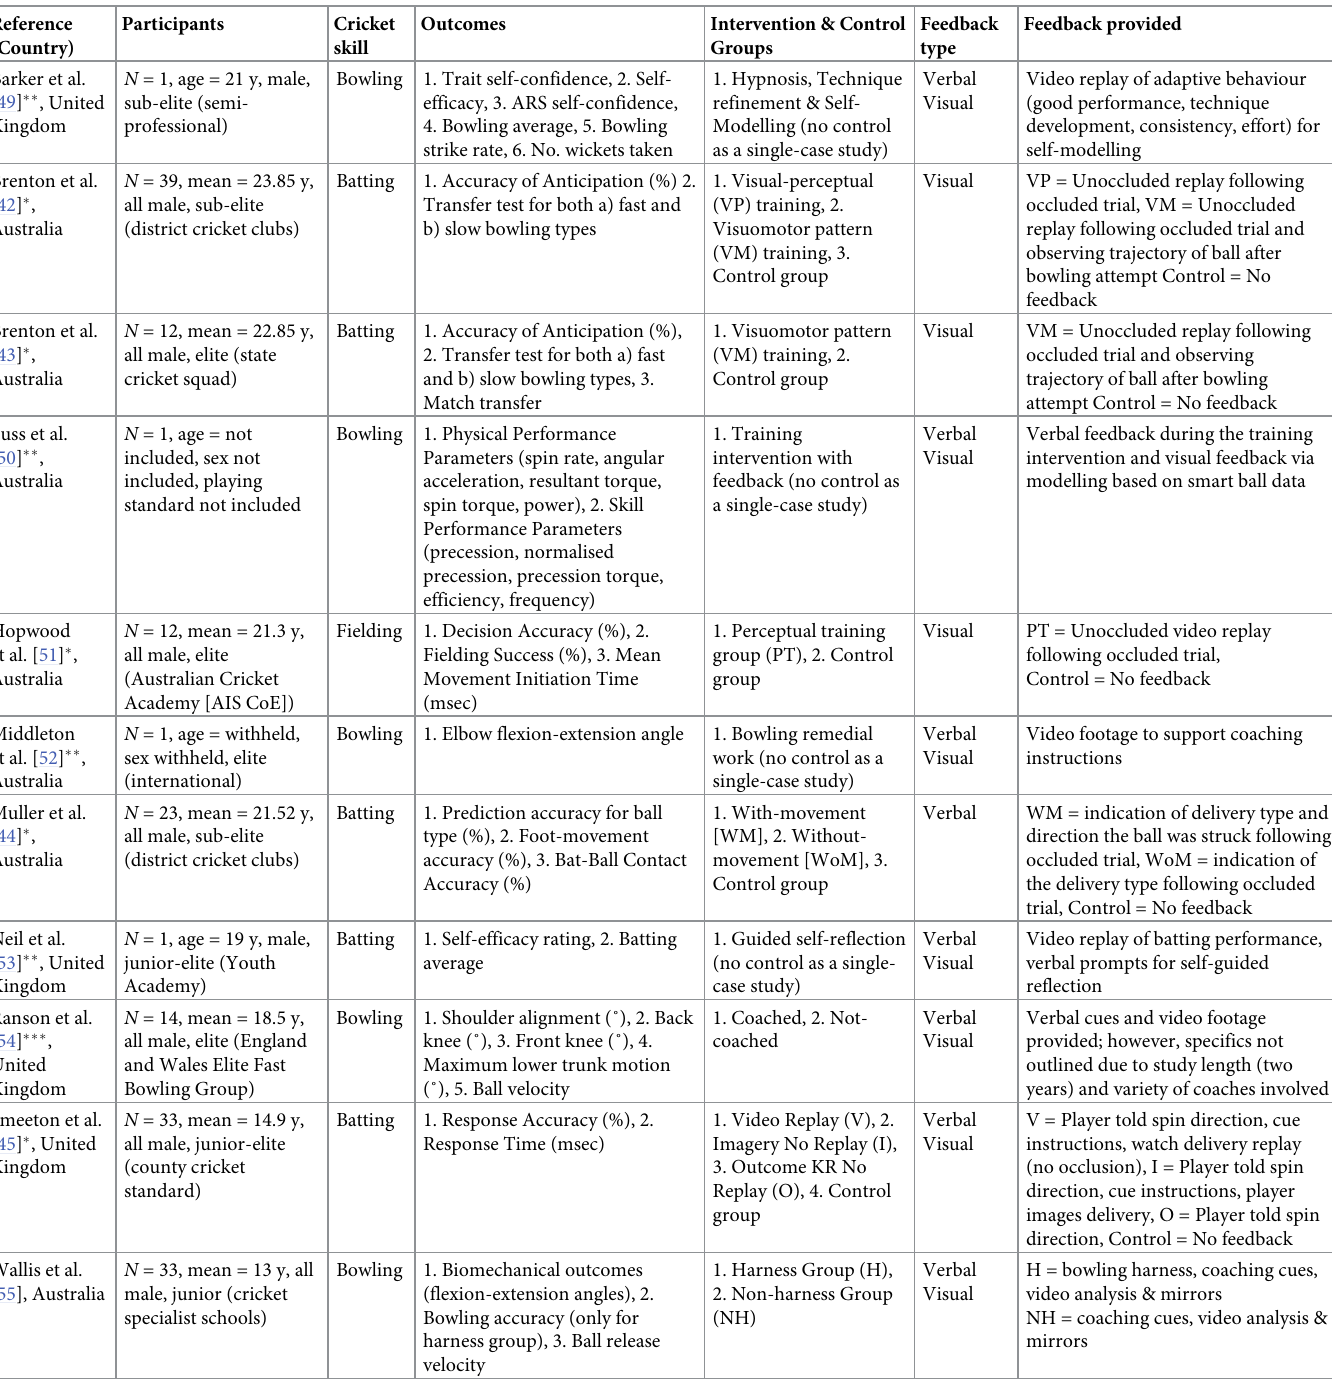
Table 1. Characteristics of studies included in systematic review and